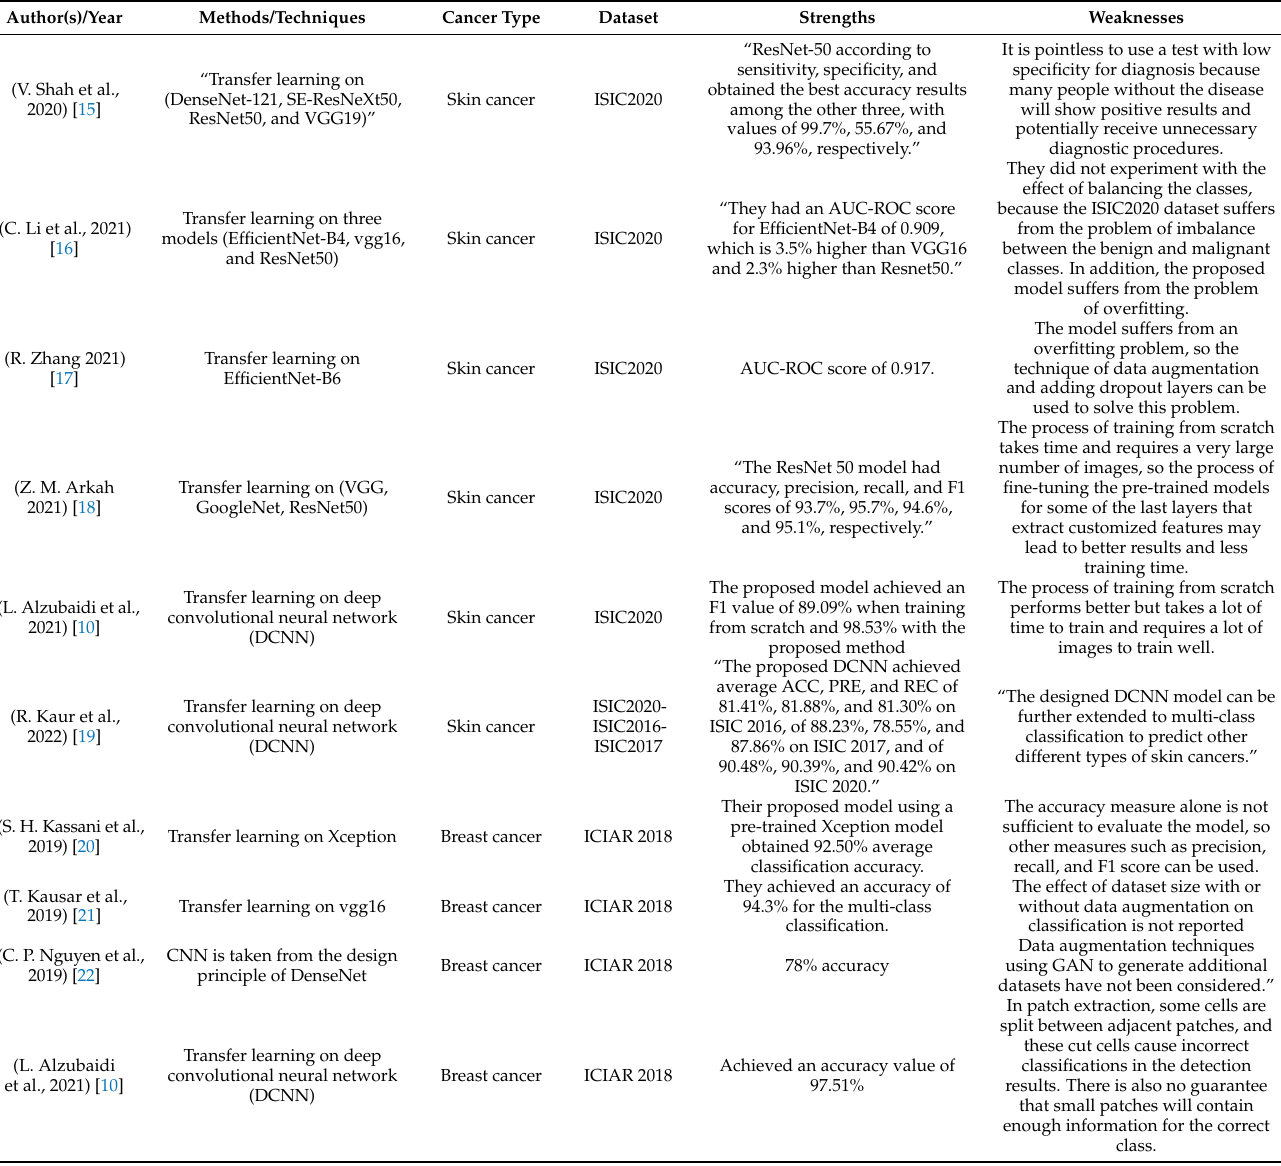
Table 1. Techniques used in the skin cancer and the breast cancer classification